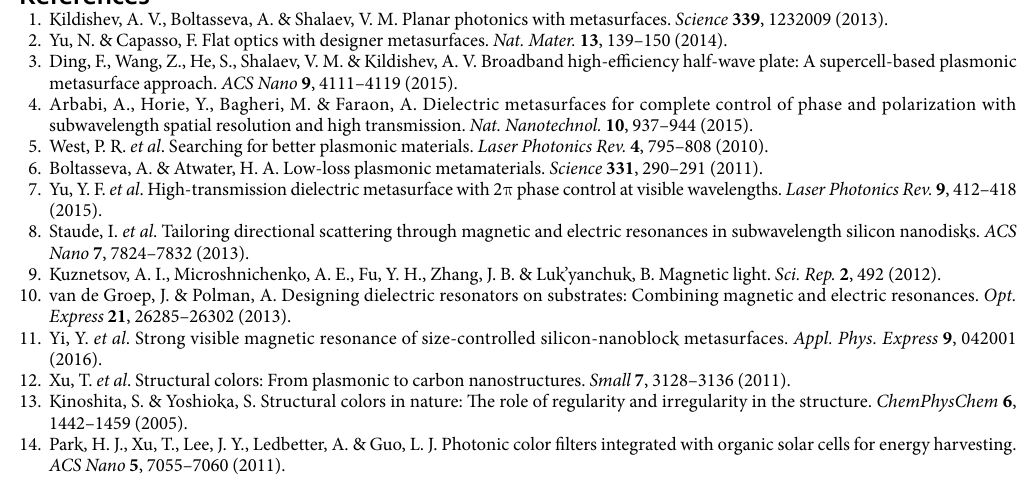
7 Scientific RepoRts | 7: 2556 | DOI:10.1038/s41598-017-02911-w